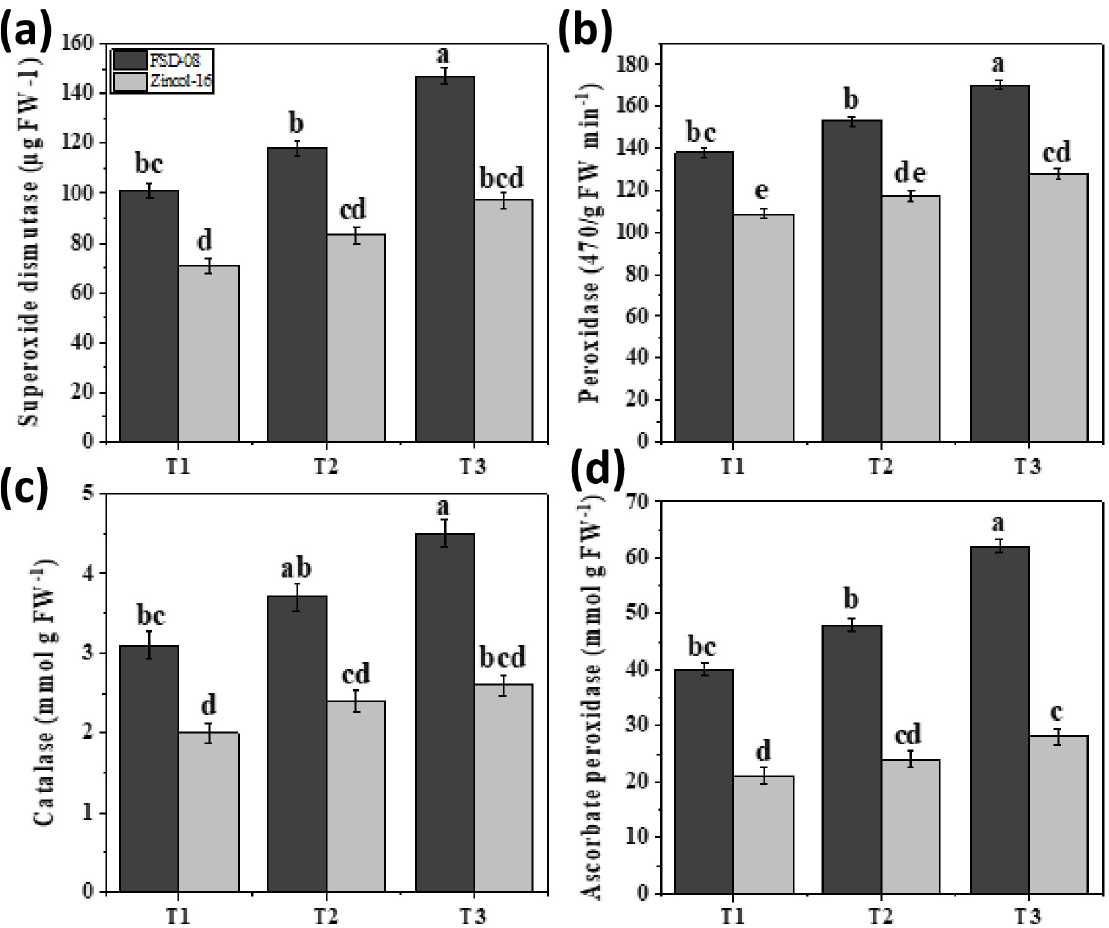
Fig 3. The effect of exogenous caffeic acid supply on (a) superoxide dismutase (SOD), (b) peroxidase (POD), (c) catalase (CAT) and (d) ascorbate peroxidase (APX) of two wheat ( Triticum aestivum L.) varieties subjected to salt stress. The bar values depict the average of three replications and the bars not sharing the same lowercase letters differ significantly from each other according to the HSD test at P < 0.05 probability. Treatments include